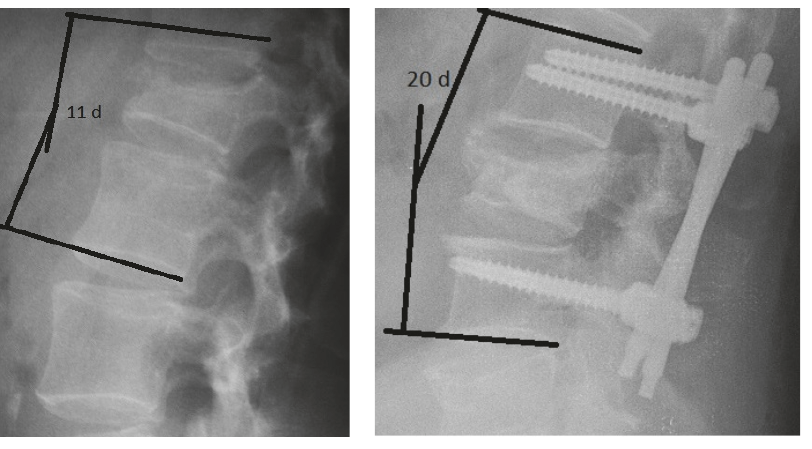
(b) Lateral roentgenogram of the patient in (a) obtained 27 months postoperatively following Sr-HA injection and short-segment pedicle screw fixation; there is a correction of the preoperative 11 ∘ kyphosis to